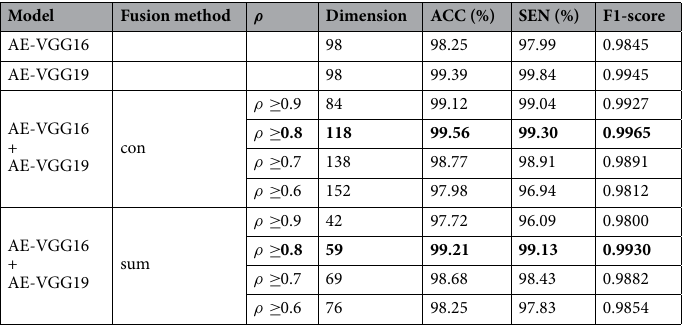
Table 6. Experimental results of selecting different feature fusion methods. Significant values are in bold.